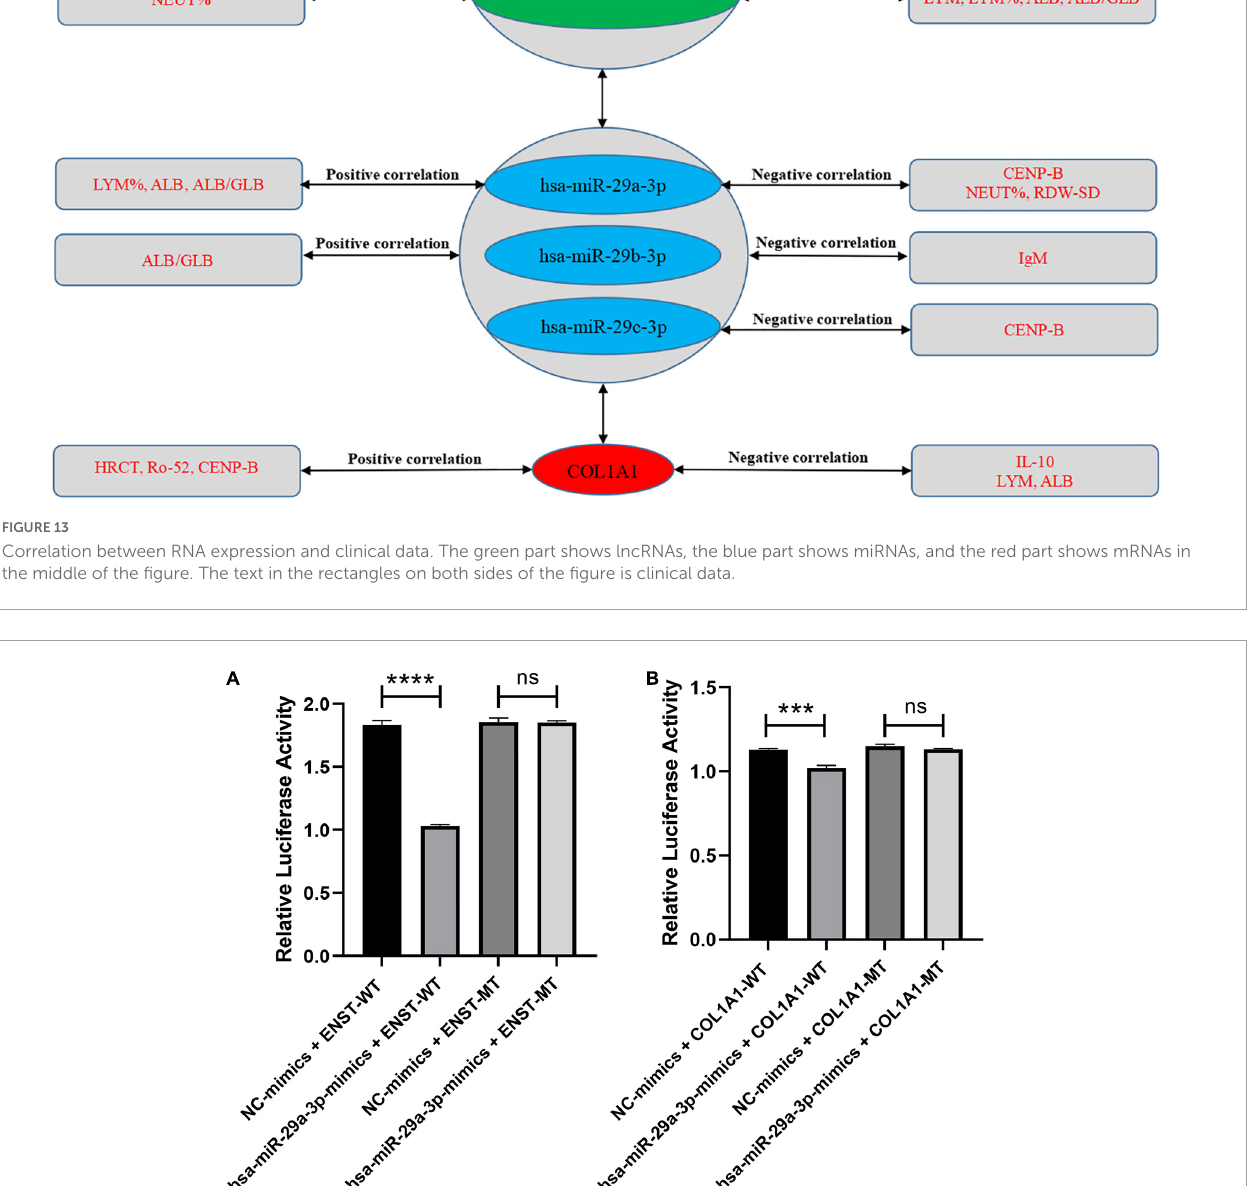
mimics + COL1A1 -WT group, the fluorescence value of the hsa- miR-29a-3p-mimics + COL1A1 -WT group decreased significantly ( P < 0.0001). There was no significant difference in the fluorescence value between the hsa-miR-29a-3p-mimics + COL1A1 -MT